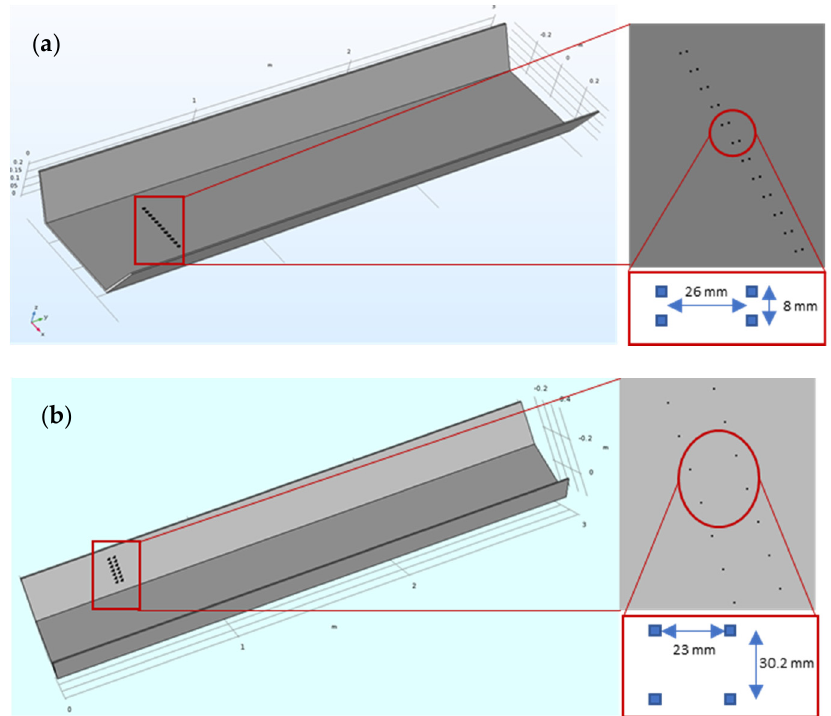
Figure 5. ( a ) 12 × 2 configuration shear transducer array for the web of the pile and ( b ) 7 × 2 configuration shear transducer array for the flange of the